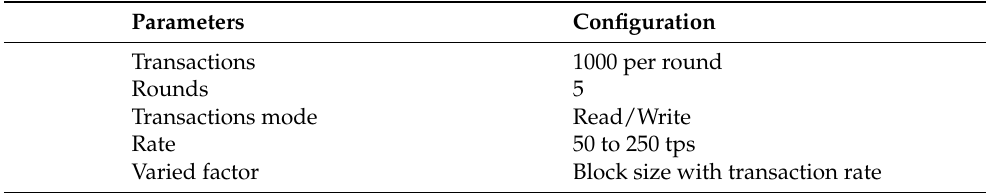
Table 2. Simulation Parameters